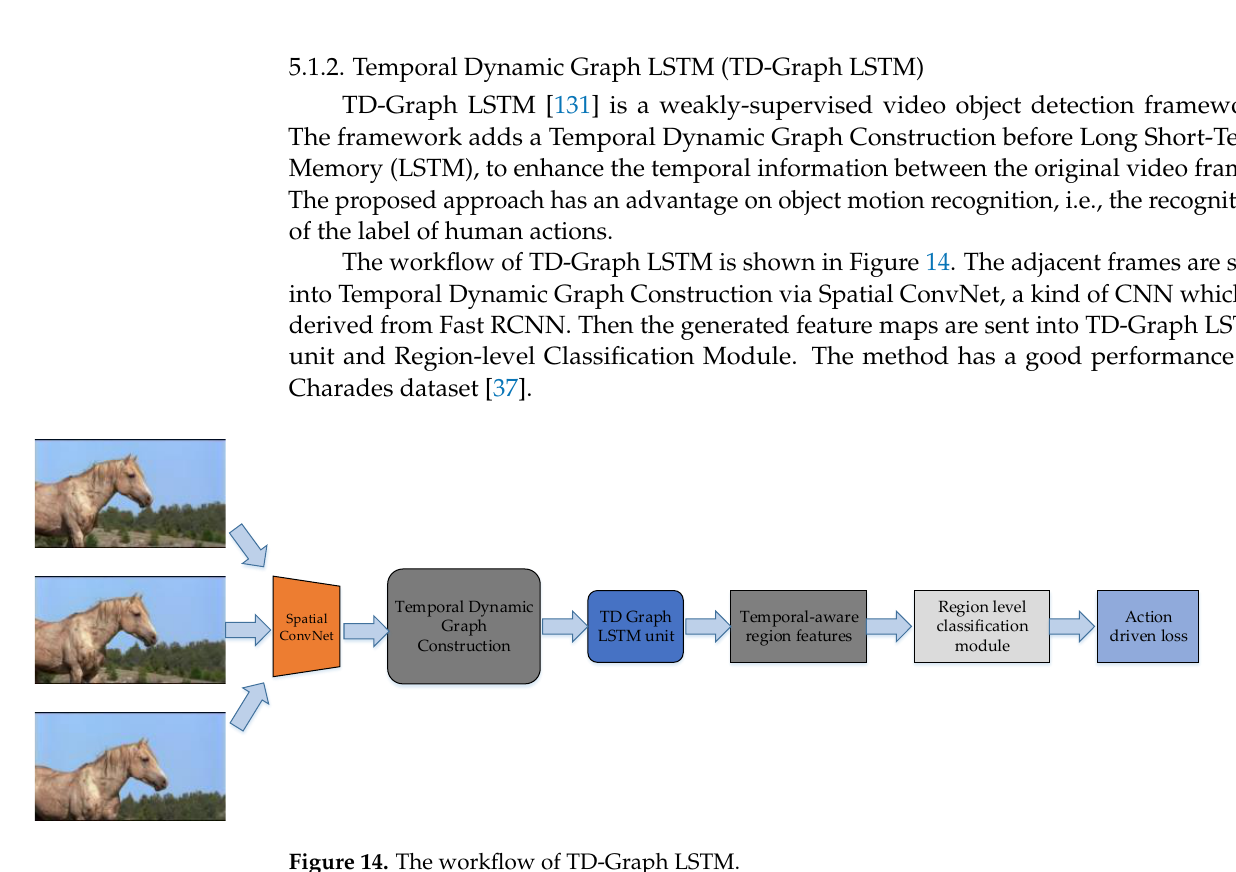
Figure 13. The architecture of Association LSTM. SSD is a one-stage detector, which is described before. FC is the fully connected layers. Association Error generates the object classification, Regres- sion Error generates the object localization.